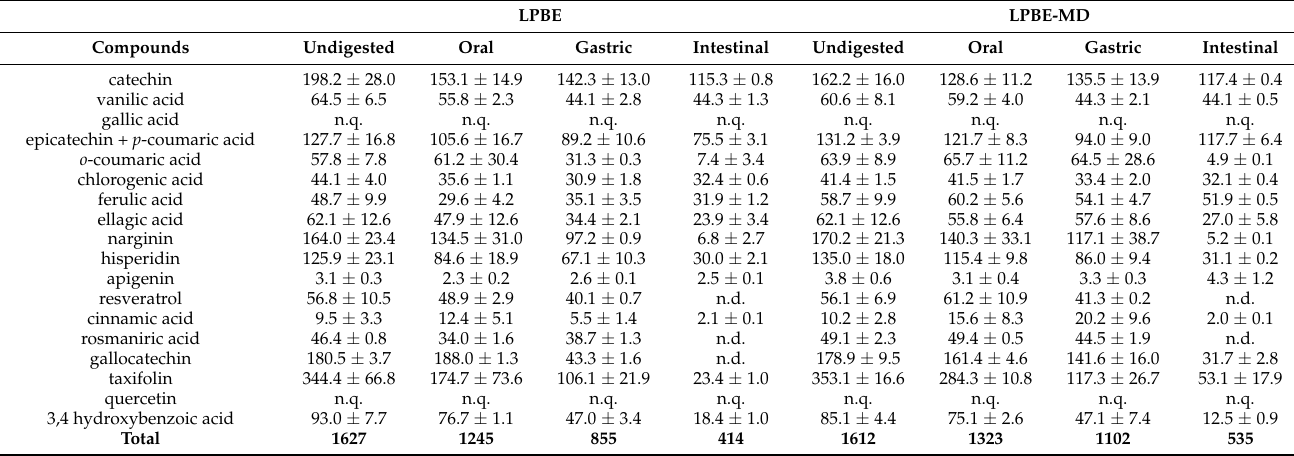
Table 4. Phenolic compounds identification and quantification of non-encapsulated (LPBE) and encapsulated (LPBE-MD) PBE before and after gastrointestinal digestion by UHPLC-DAD. LPBE LPBE-MD Compounds Undigested Oral catechin